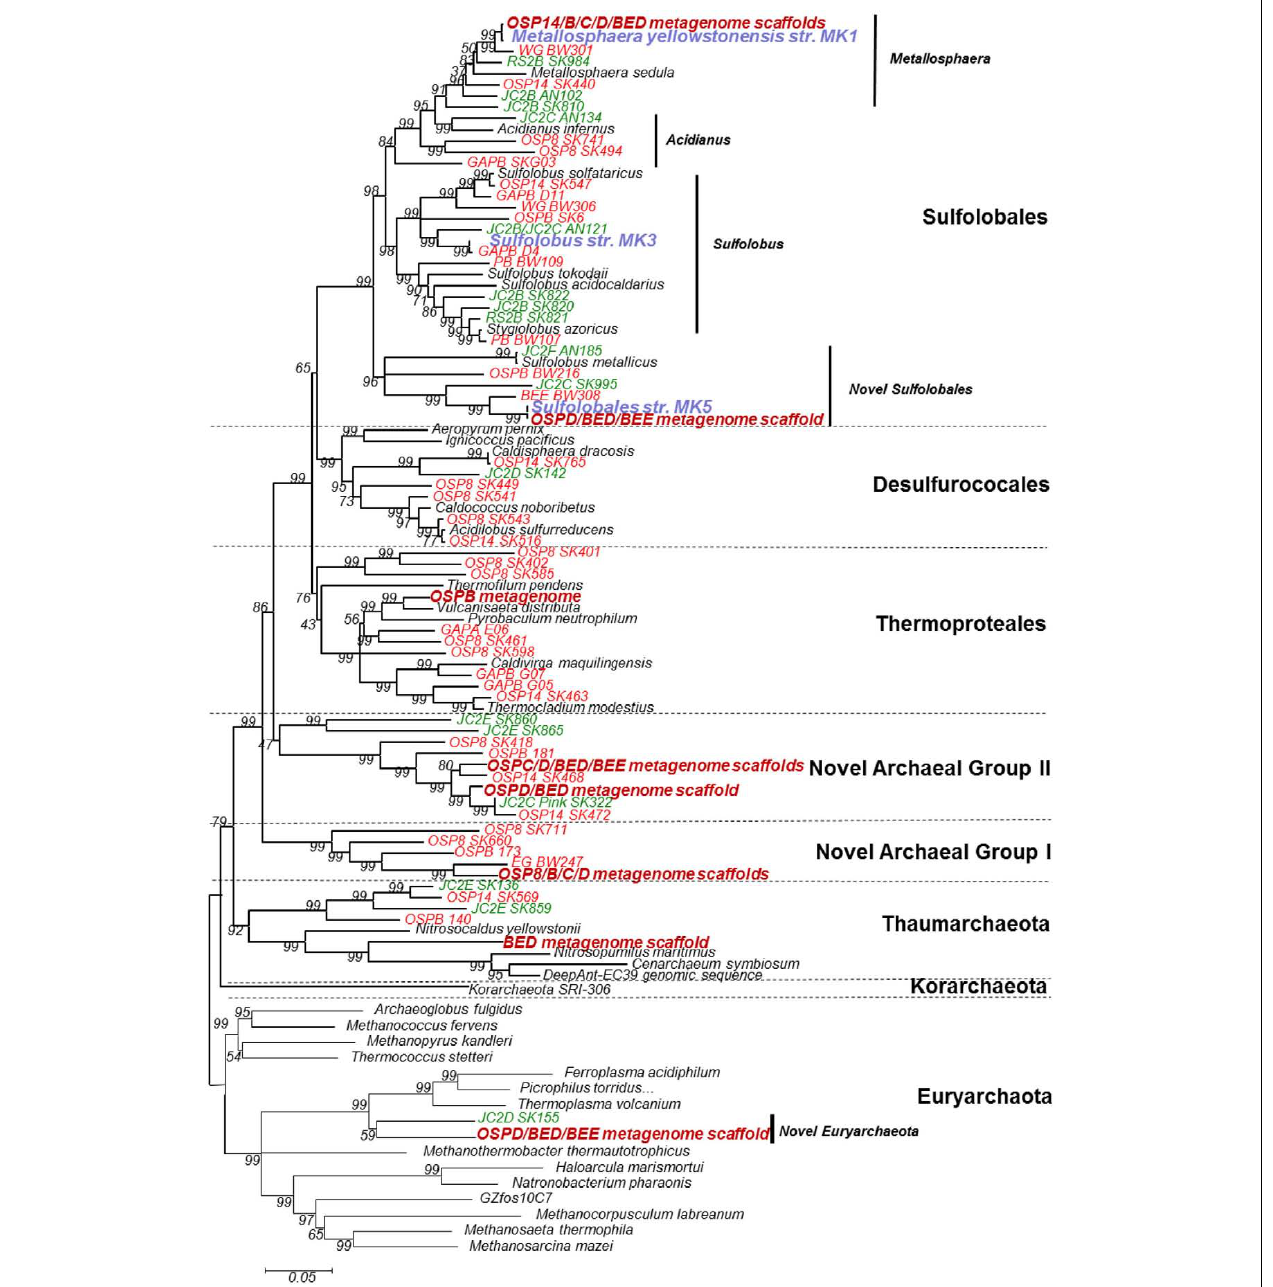
FIGURE 6 | Phylogenetic tree of archaeal 16S rRNA gene sequences (sequence length ∼ 1400bp) observed across 19 different acidic iron mat samples fromYellowstone National Park (acid-sulfate-chloride springs are shown in red, acid-sulfate springs shown in green, isolates are highlighted in blue, and metagenome sequence entries are listed in dark